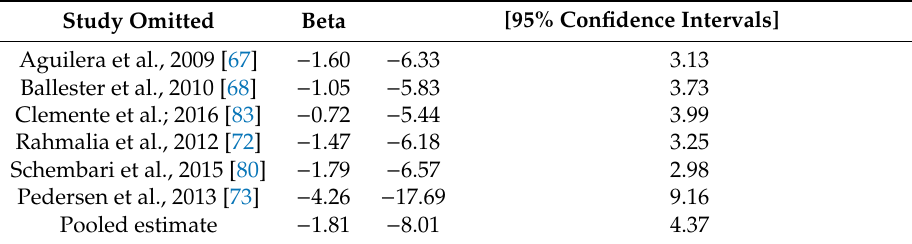
Table A2. Sensitivity analysis: birth weight and NO 2 exposure during the whole pregnancy. Study Omitted